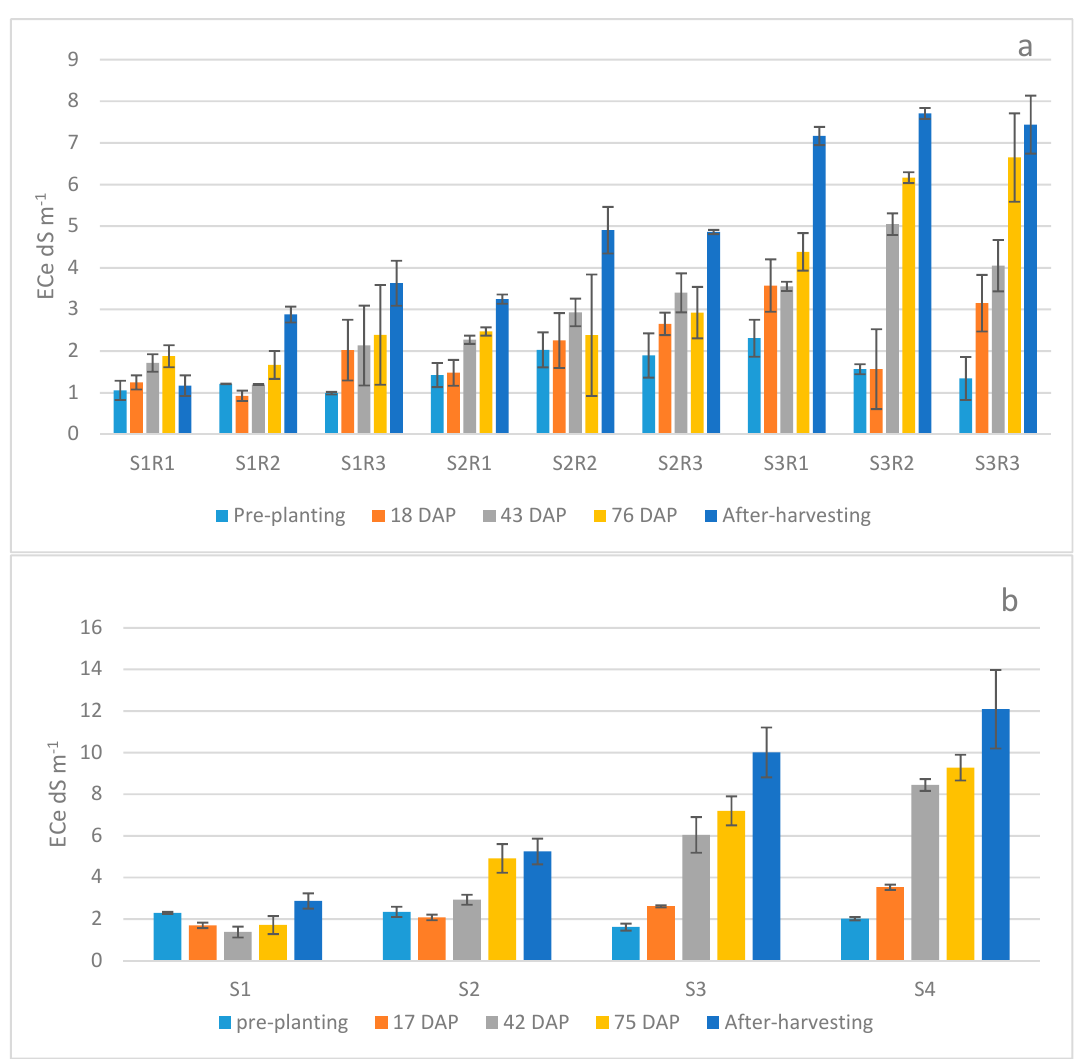
which was determined by RAW (Readily Available Water).